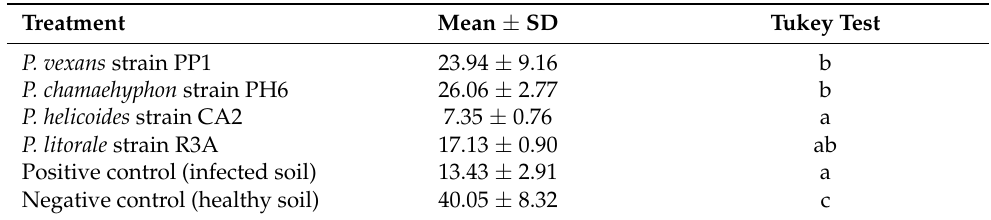
Table 3. Dry weight (g) of roots sampled from 1-year-old plants of A. chinensis var. deliciosa ‘Hayward’ plants after 26 dpi. Values in the same column followed by the same letter are not statistically different by Tukey test ( p ≤